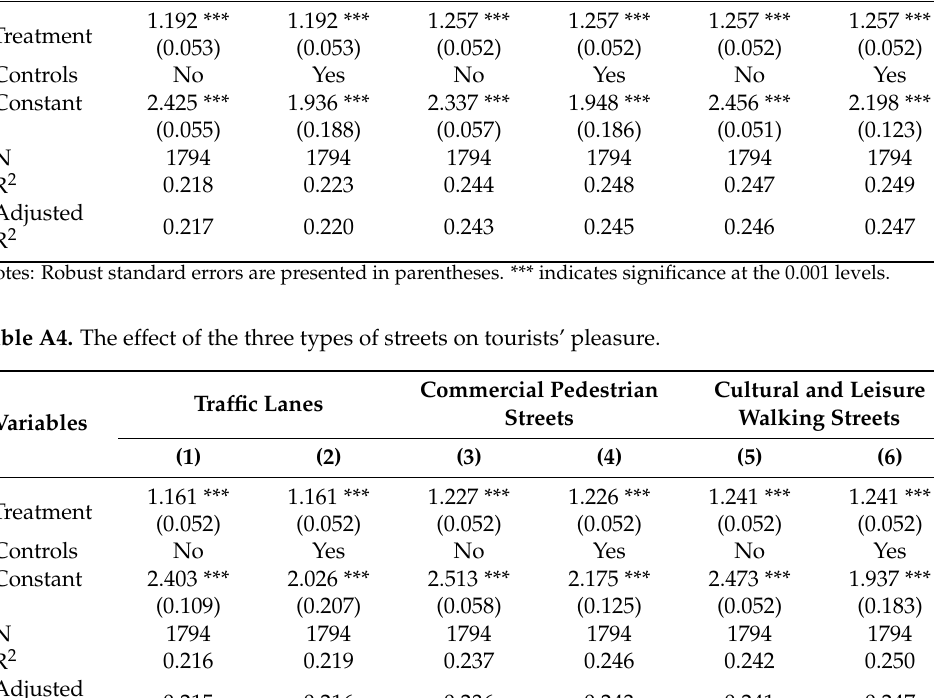
Table A3. The effect of the three scales of intervention on tourists’ arousal. Variables Treatment